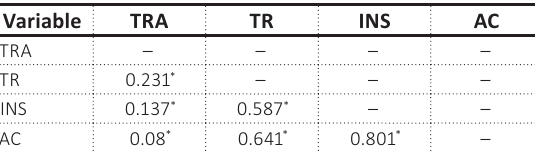
Table 3. Discriminant validity